Question: From the figure, is the trend upward or downward?
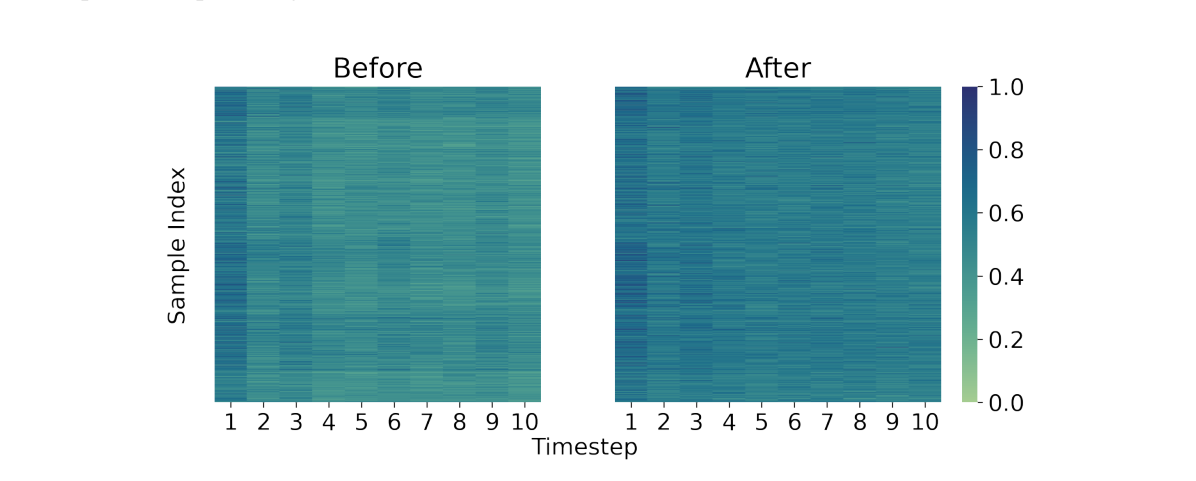
Answer: increasing